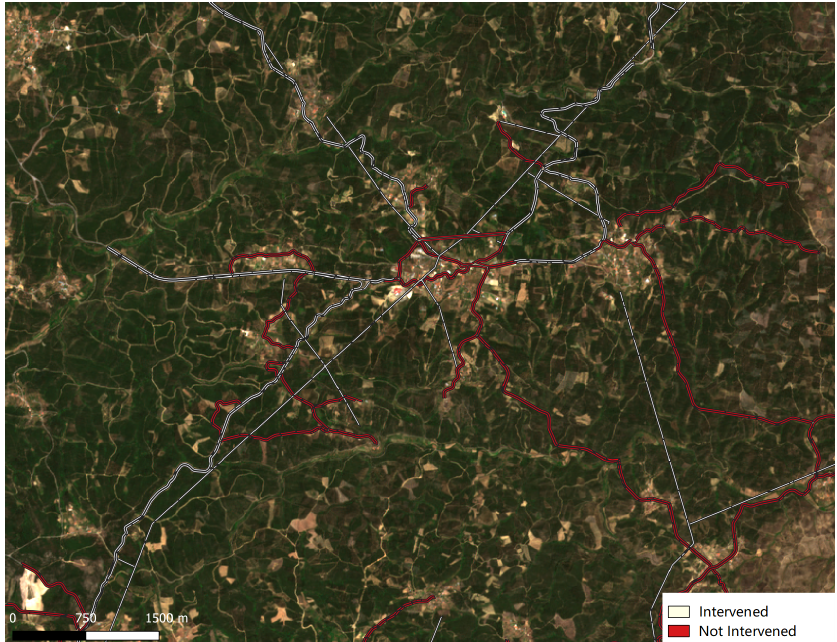
Figure 2. Fuel Management Zones (FMZs) along roads and powerlines, in the north of Mação, which were treated in